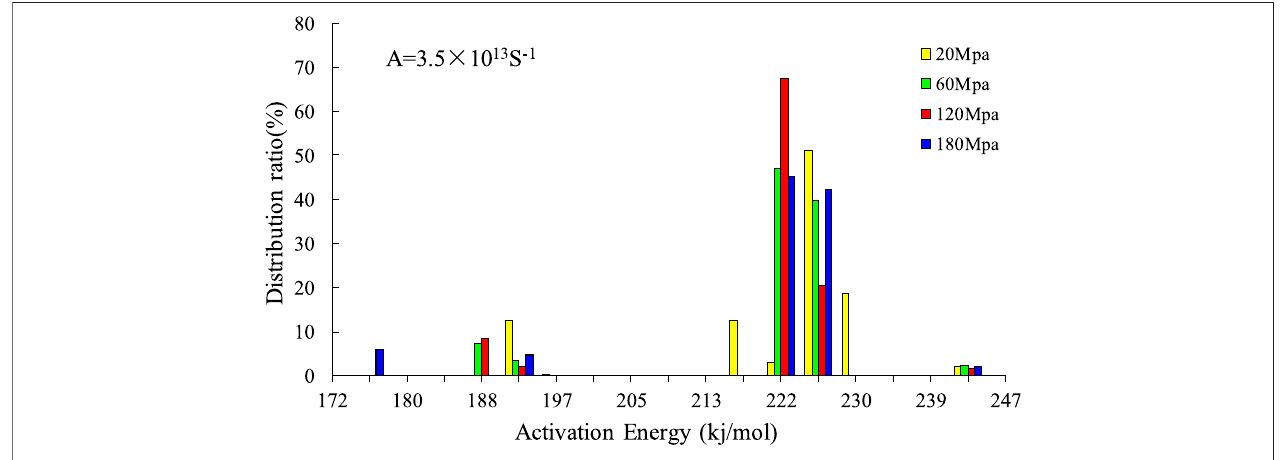
FIGURE 12 | Comparison of distribution of activation energy of hydrocarbon generation of sample 2,911 under different pressure conditions.